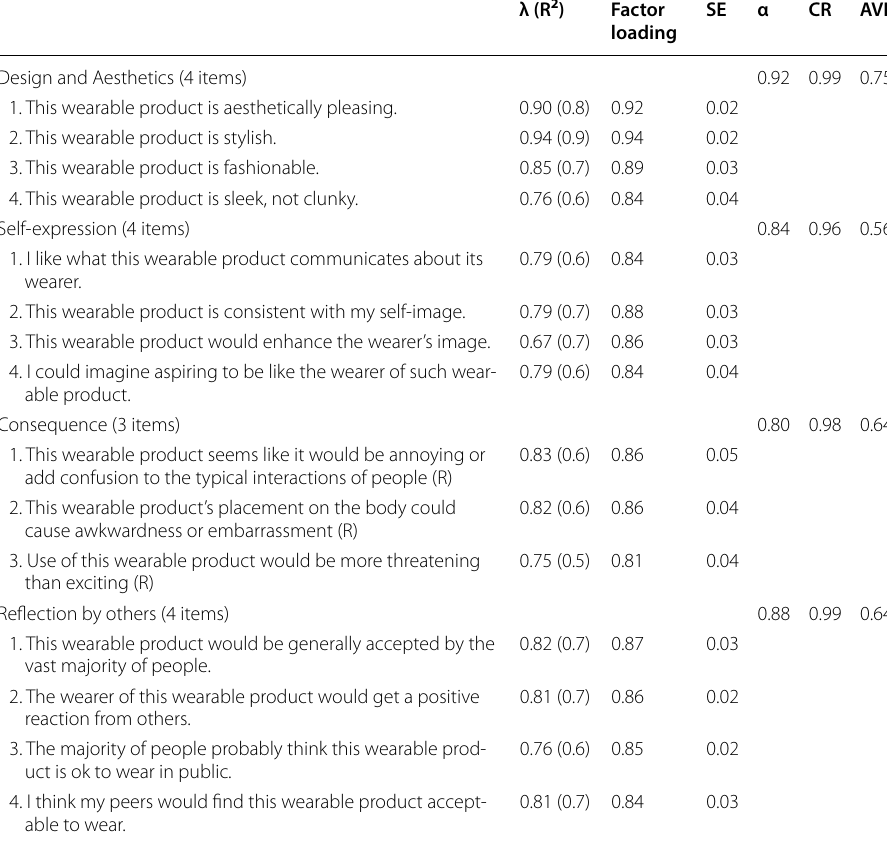
Table 5 Factor reliabilities for smart clothing and footwear with 15